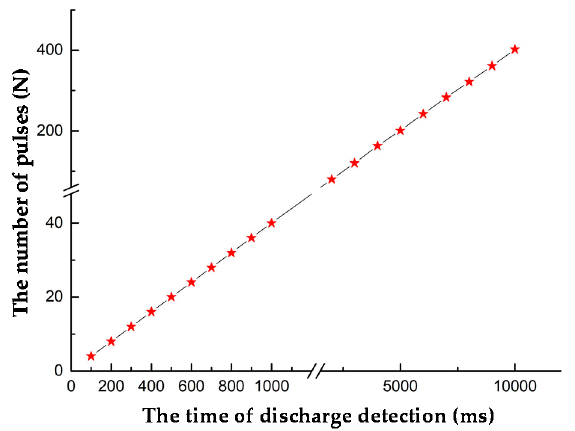
Figure 9. Test results of the periodic UV discharge system.